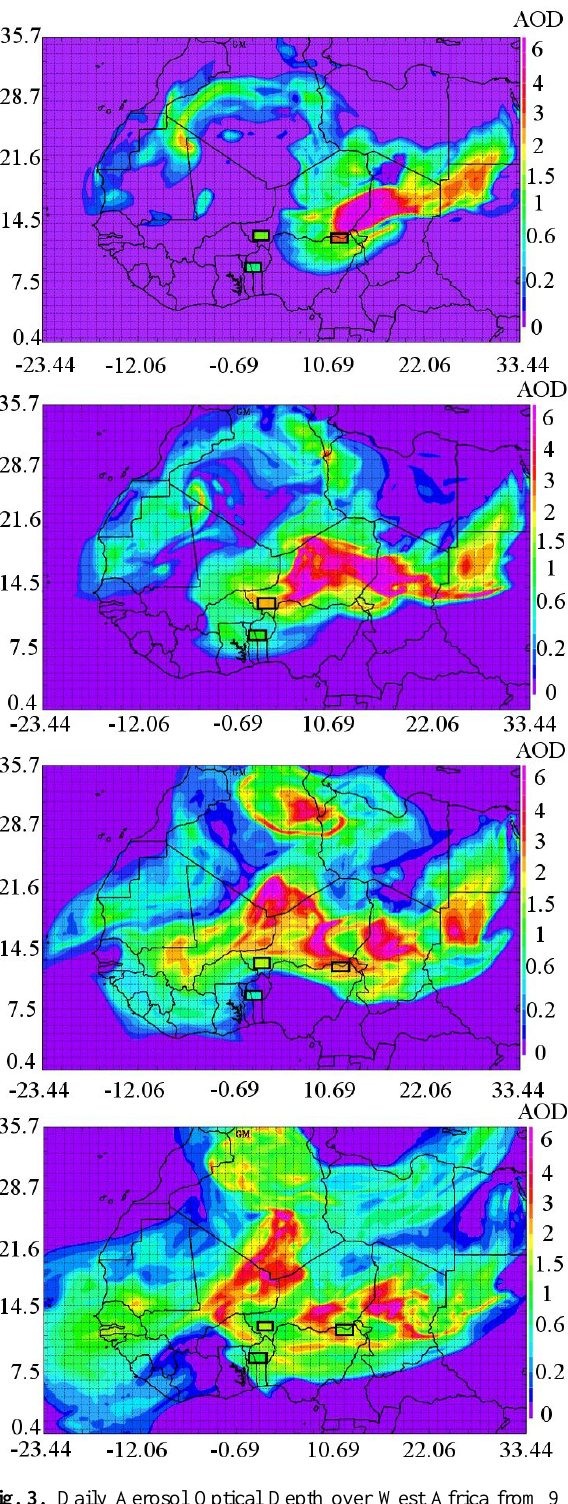
Fig. 3. Daily Aerosol Optical Depth over West Africa from 9 to 12 June 2006, around 12:00UTC. The simulated AOD values are represented on the whole domain while the observed AOD are rep- resented in boxes.